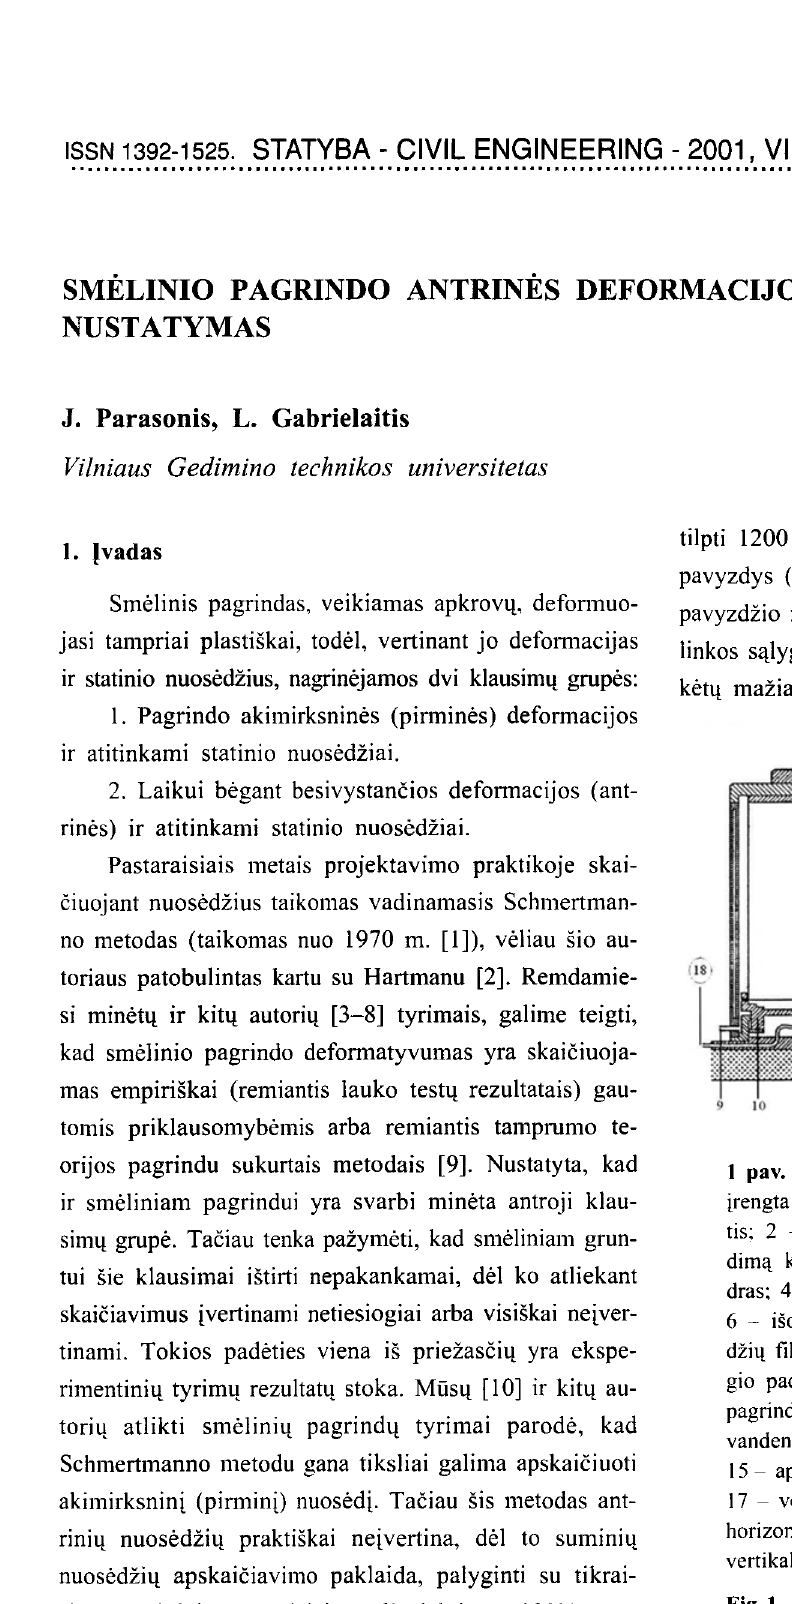
Fig 1. Plate load testing in calibration chamber: a) plate installation~ b) plate assembly Smelio pavyzdys yra dedamas tarp dviejq kamerq: isorines, kuri yra tarp dvigubo cilindro sieneliq,